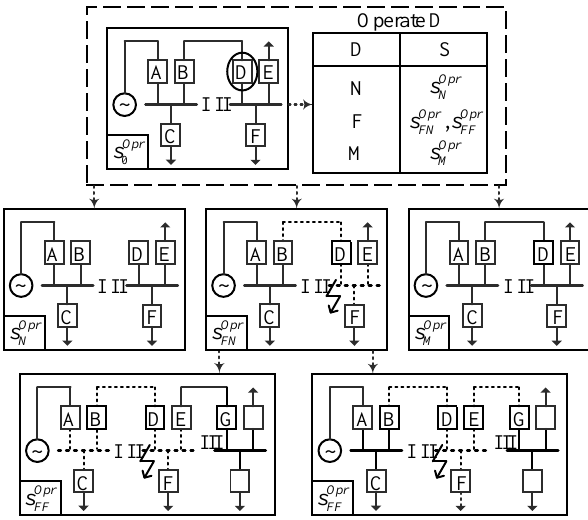
Figure 4. The transition of grid state after breaker D is operated.